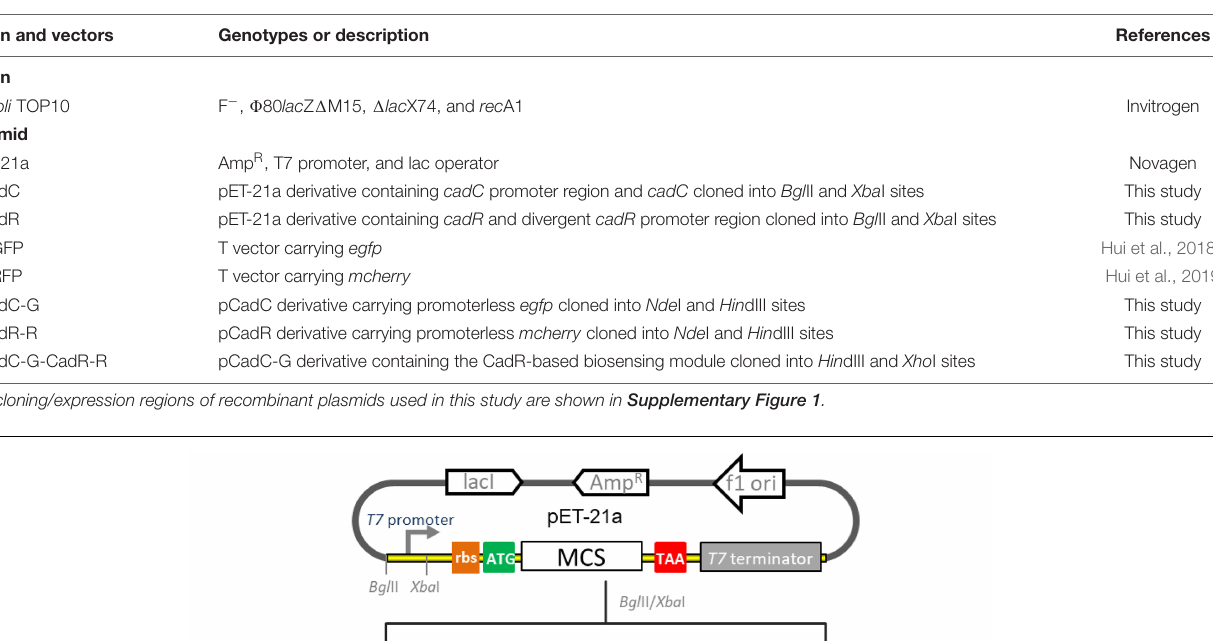
TABLE 1 | Bacterial strains and plasmids used in this study.